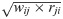
Illustrating the apparent similarity problem.(a) the description of a unweighted undirected object-user bipartite network, with objects denoted by squares and users by round circles. (b) Matrices W, RF, RB and MC indicate similarity matrix of NBI, forward and backward similarity proportion matrices and corrected similarity matrix, respectively. Color circles highlight the corresponding relations of similarity elements in different similarity matrices. Here element mij in MC equals to wij×rji, with wij in W = RF and rji in RB.